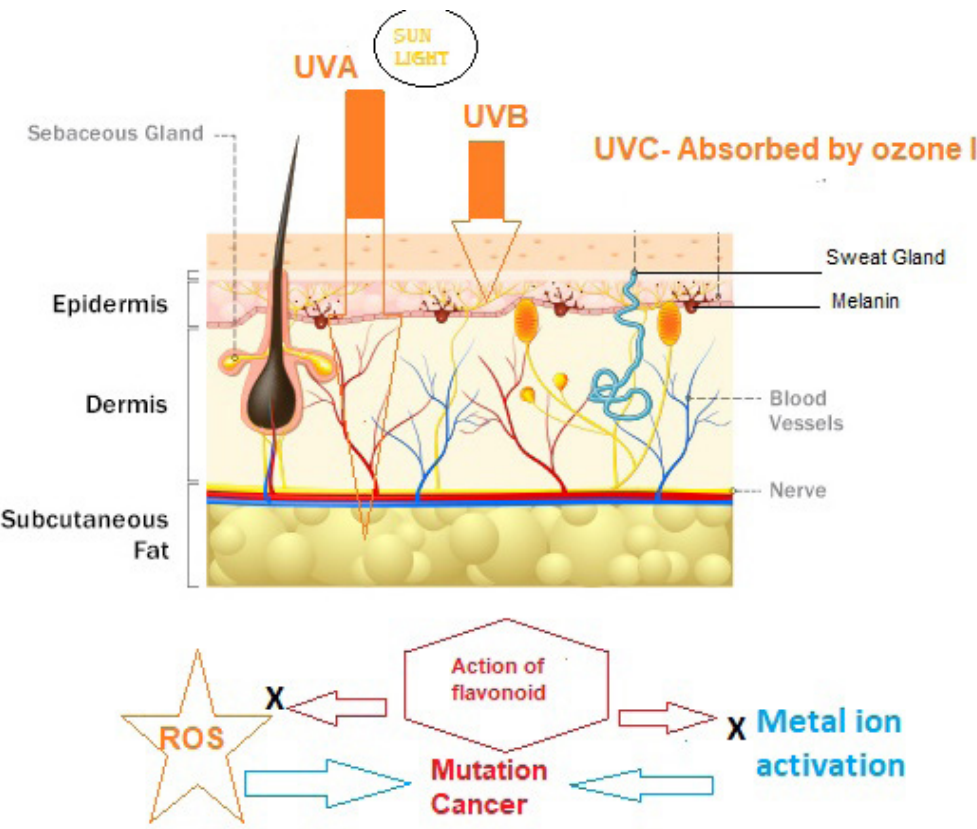
FIGURE 2 - General mechanism of action of